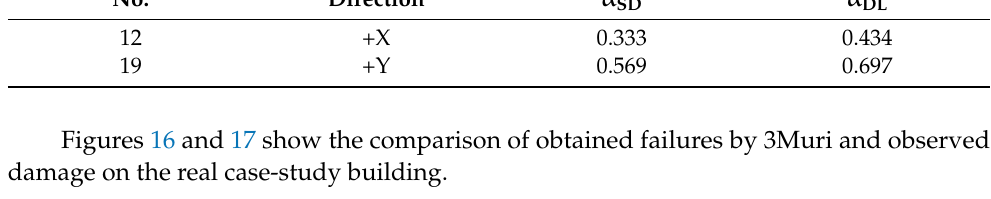
Table 4. Values of vulnerability index α for the most significant analysis in the x and y